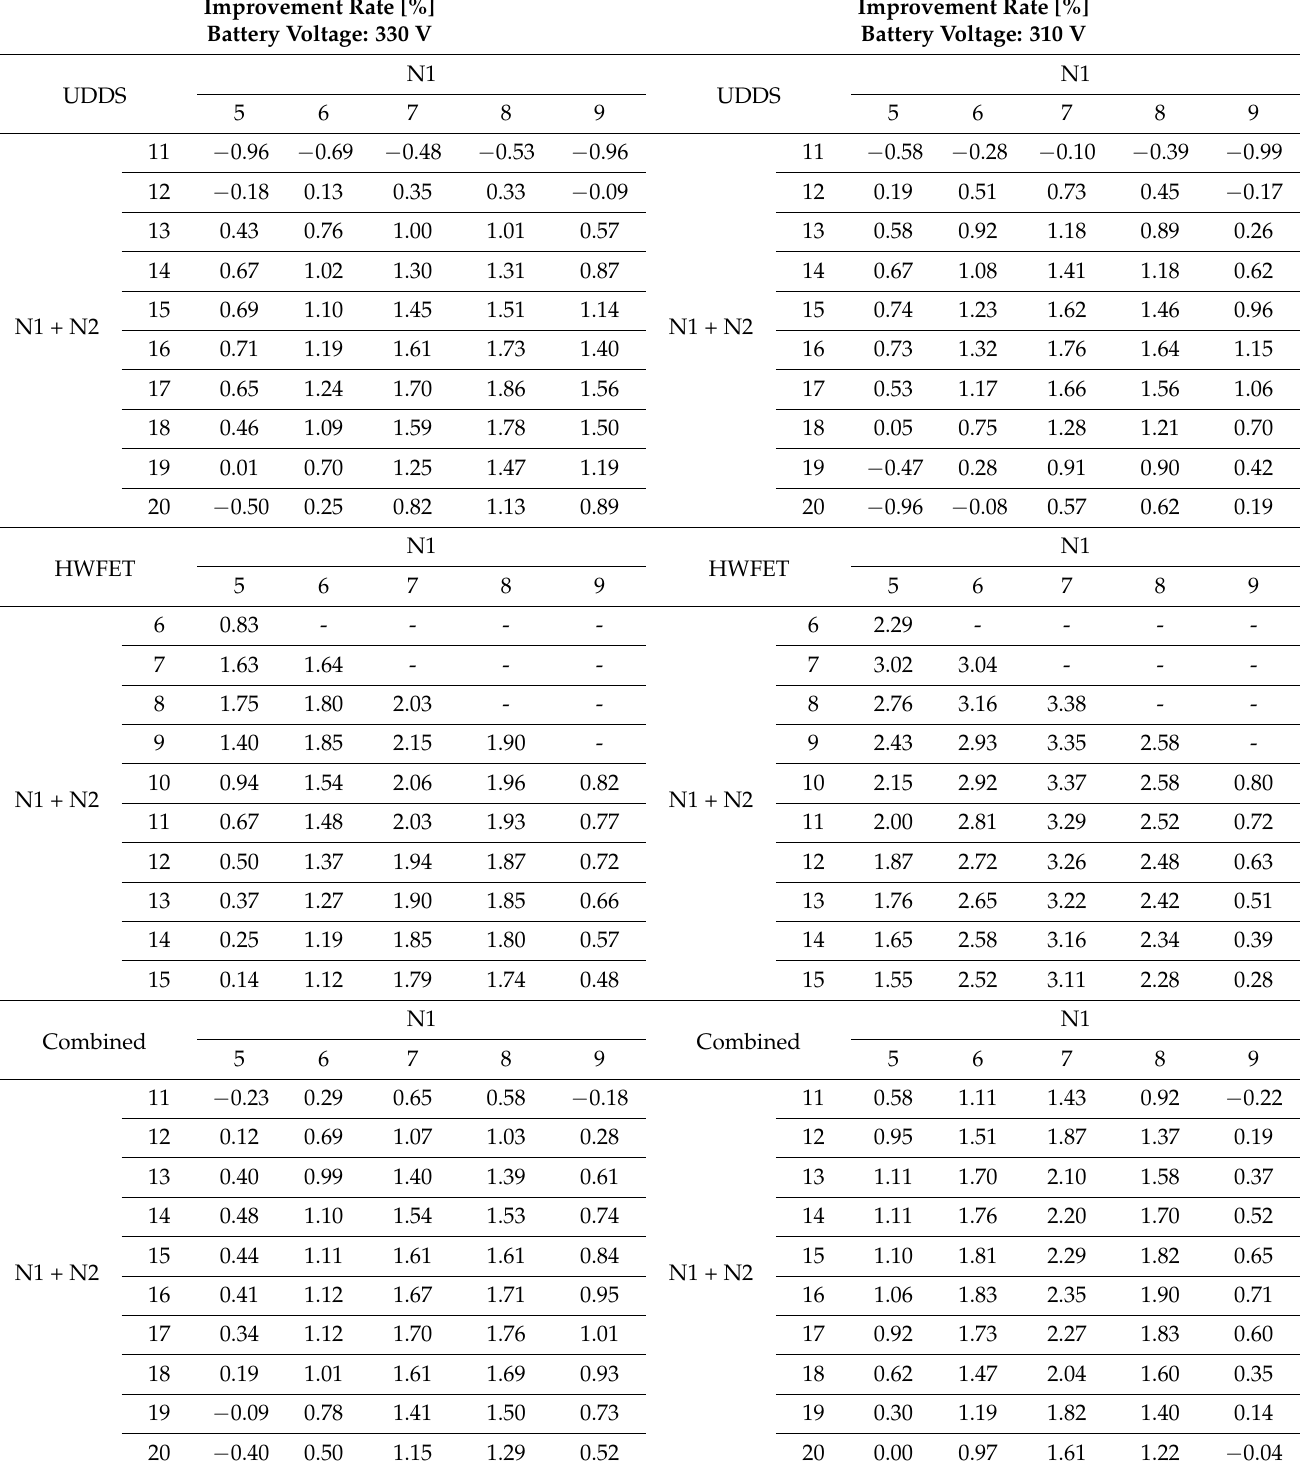
Table 2. Energy consumption reduction rate